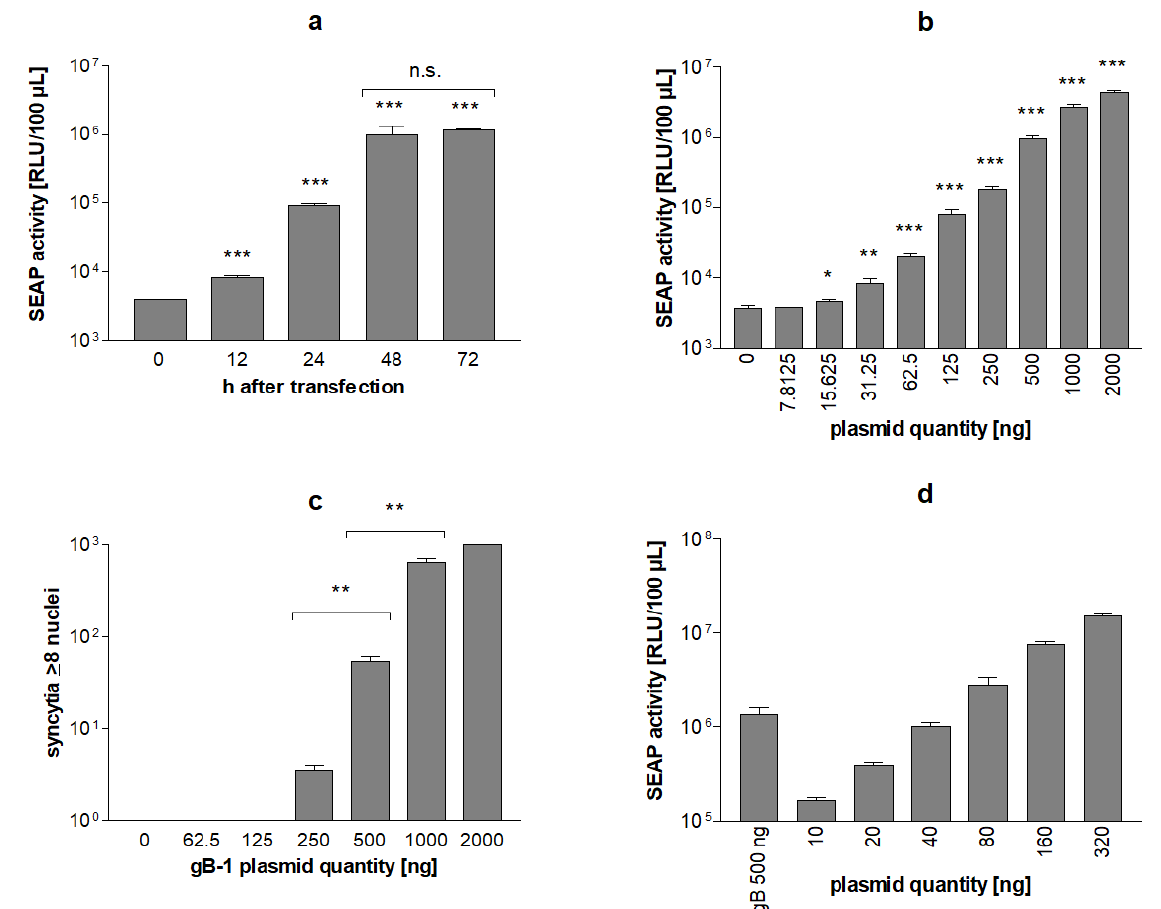
Figure 4. Syncytia formation by HSV-1 fusion machinery in Vero reporter cells induces SEAP expression. Time kinetics of SEAP expression are shown in panel ( a ). 2 × 10 5 reporter cells cultivated in 24-well plates were transfected with gB-1 (500 ng), and gD-1, gH-1, and gL-1 plasmid (660 ng each), SEAP levels were quantified 12 to 72 h after transfection as indicated. The effect of gB-1 levels on SEAP expression is shown in panel ( b ). Cells were transfected with varying amounts of gB-1 plasmid as indicated and fixed amounts of gD-1, gH-1 and gL-1 (660 ng each), SEAP levels were quantified 48 h after transfection. Microscopical quantification of syncytia formation in reporter cells is shown in panel ( c ). Reporter cells cultivated in 24 well plates were transfected with fixed amounts of gD-1, gH-1, and gL-1 (660 ng each) and varying concentrations of gB-1 as indicated, fixed 48 h after transfection, stained with Giemsa and the number of syncytia with ≥ 8 nuclei was determined microscopically. Comparison of SEAP levels induced by syncytia formation and by direct transfection of indicator cells with the SEAP reporter plasmid is shown in panel ( d ). Reporter cells were either transfected with 500 ng gB-1 plasmid and 660 of gD-1, gH-1 and gL-1 plasmid each or with varying amounts of pTRE3G-SEAP-EYFPNuc as indicated. Data represent means ± SD from quadruplicates. Significance is indicated compared to 0 ng plasmid values, p < 0.05 (*), p < 0.01 (**) and p < 0.001 (***).